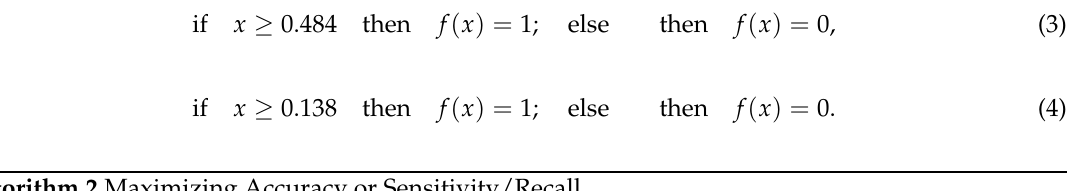
Algorithm 2 Maximizing Accuracy or